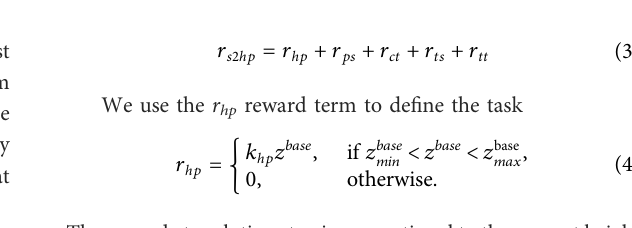
Frontiers in Robotics and